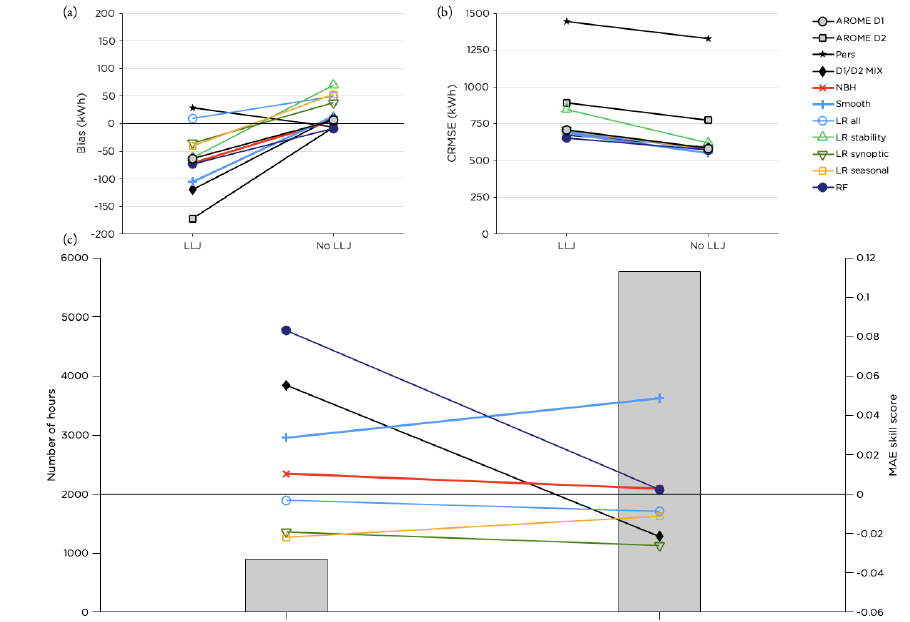
Figure 12. Performance of the post-processing methods for cases when an LLJ is forecasted compared to when there is no LLJ in the wind profile. Panel (a) shows the bias, panel (b) the CRMSE and panel (c) the MAE skill score for the methods with the highest scores together with the distribution of the number of hours with or without an LLJ in the forecast during the test